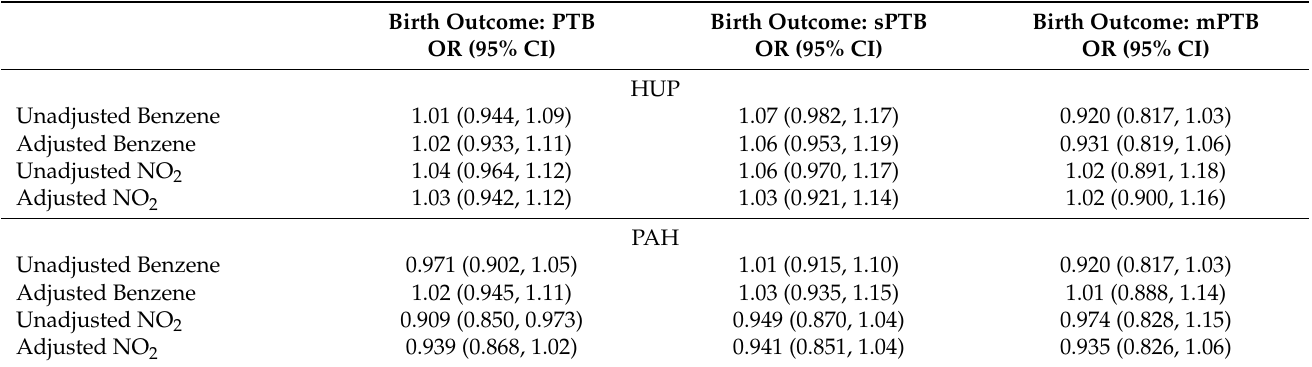
Table A1. Unadjusted and adjusted a odds ratios (OR) of a standard deviation increment increase in NO 2 and benzene with preterm birth (PTB), spontaneous PTB (sPTB) and medically indicated PTB (mPTB), stratified by hospital of birth. Birth Outcome: